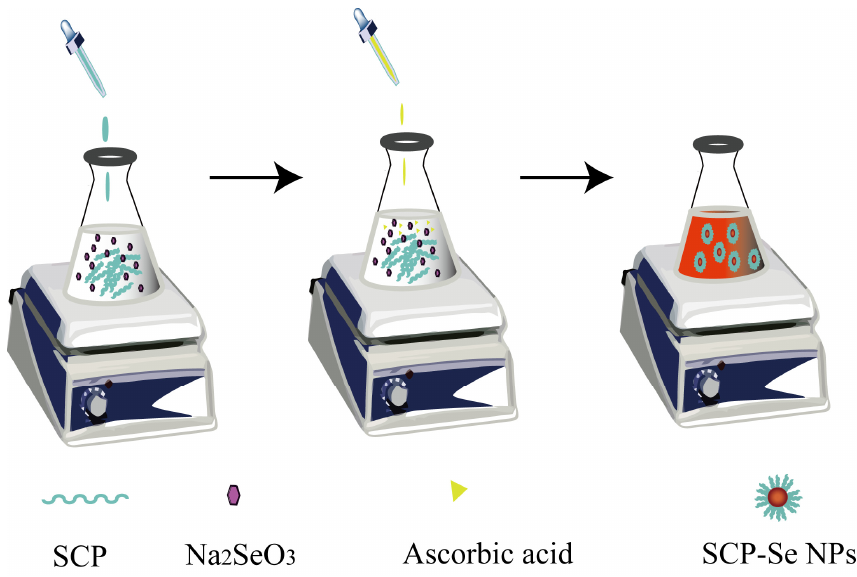
Figure 1. The schematic diagram of SCP-Se NPs